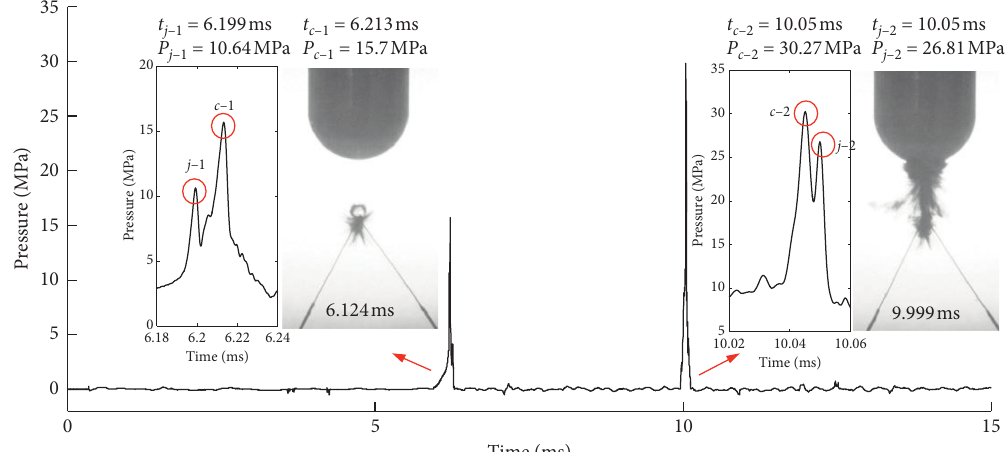
Figure 20: Pressure-time diagram of the first and second cycles of the electric-spark-generated bubble load for c � 1.17.